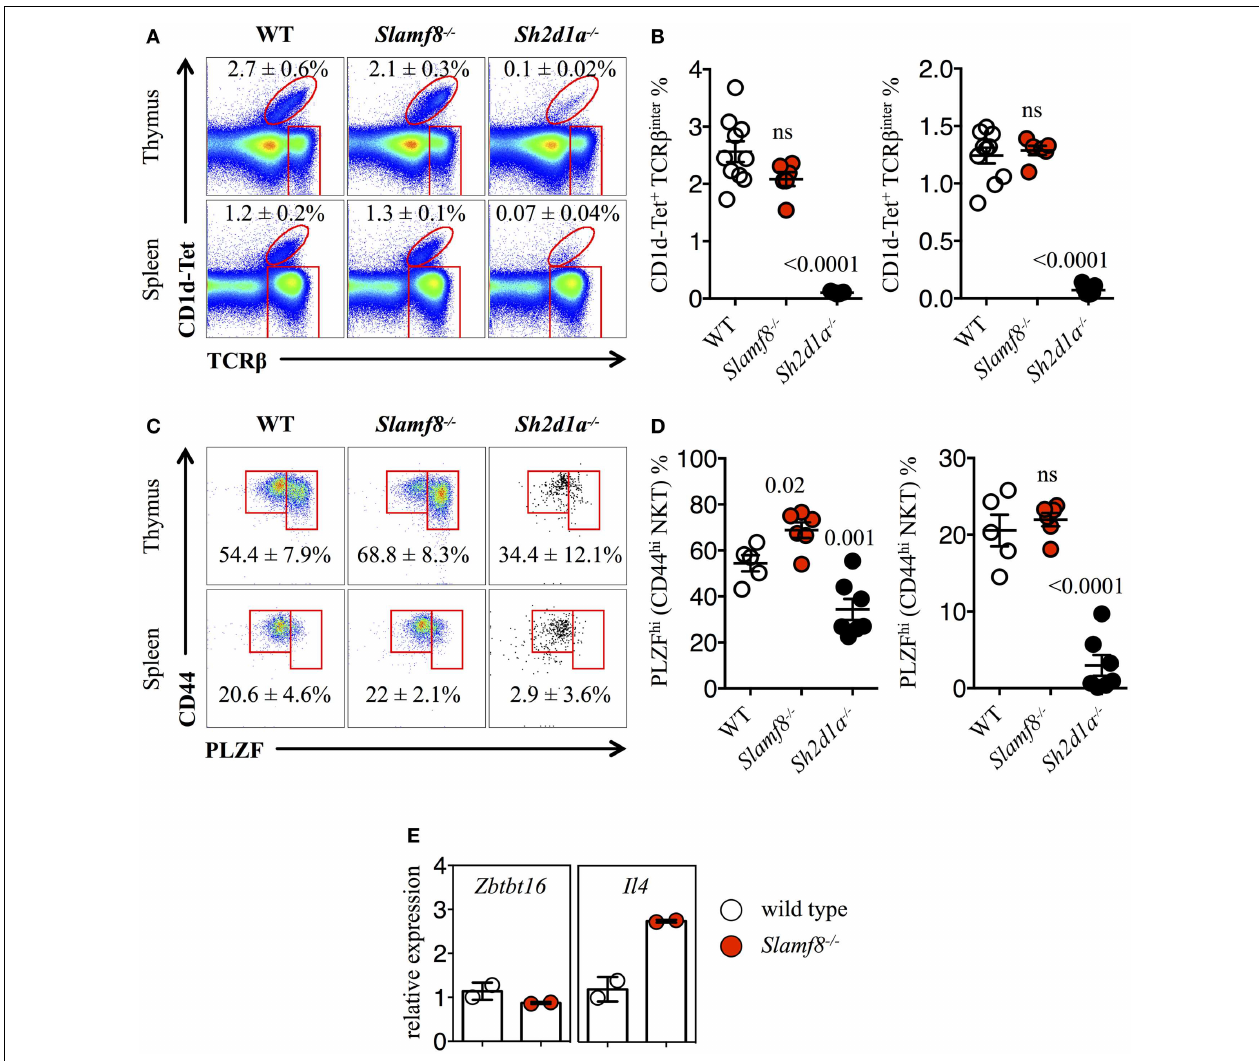
FIGURE 6 | Increased percentage of PLZF hi NKT cells in Slamf8 − / − mice . (A) Representative FACS plots showing PBS-57 CD1d-tetramer (CD1d-Tet) reactive NKT cells from thymus or spleen ofWT, Slamf8 − / − or Sh2d1a − / − BALB/c mice. FACS plots are gated on live singlets lymphocytes. (B) Percentage of CD1d-Tet + TCR β inter cells in thymus ( left ) or CD1d-Tet + TCR β + in spleen ( right ). (C) Intracellular staining for the transcription factor promyelocytic leukemia zinc finger (PLZF) in thymus or spleen ofWT, Slamf8 − / − or Sh2d1a − / − BALB/c mice. FACS plots are gated on live singlets CD1d-Tet + TCR β inter cells. (D) Percentage of PLZF hi NKT cells in thymus ( left ) or spleen ( right ) ofWT, Slamf8 − / − or Sh2d1a − /